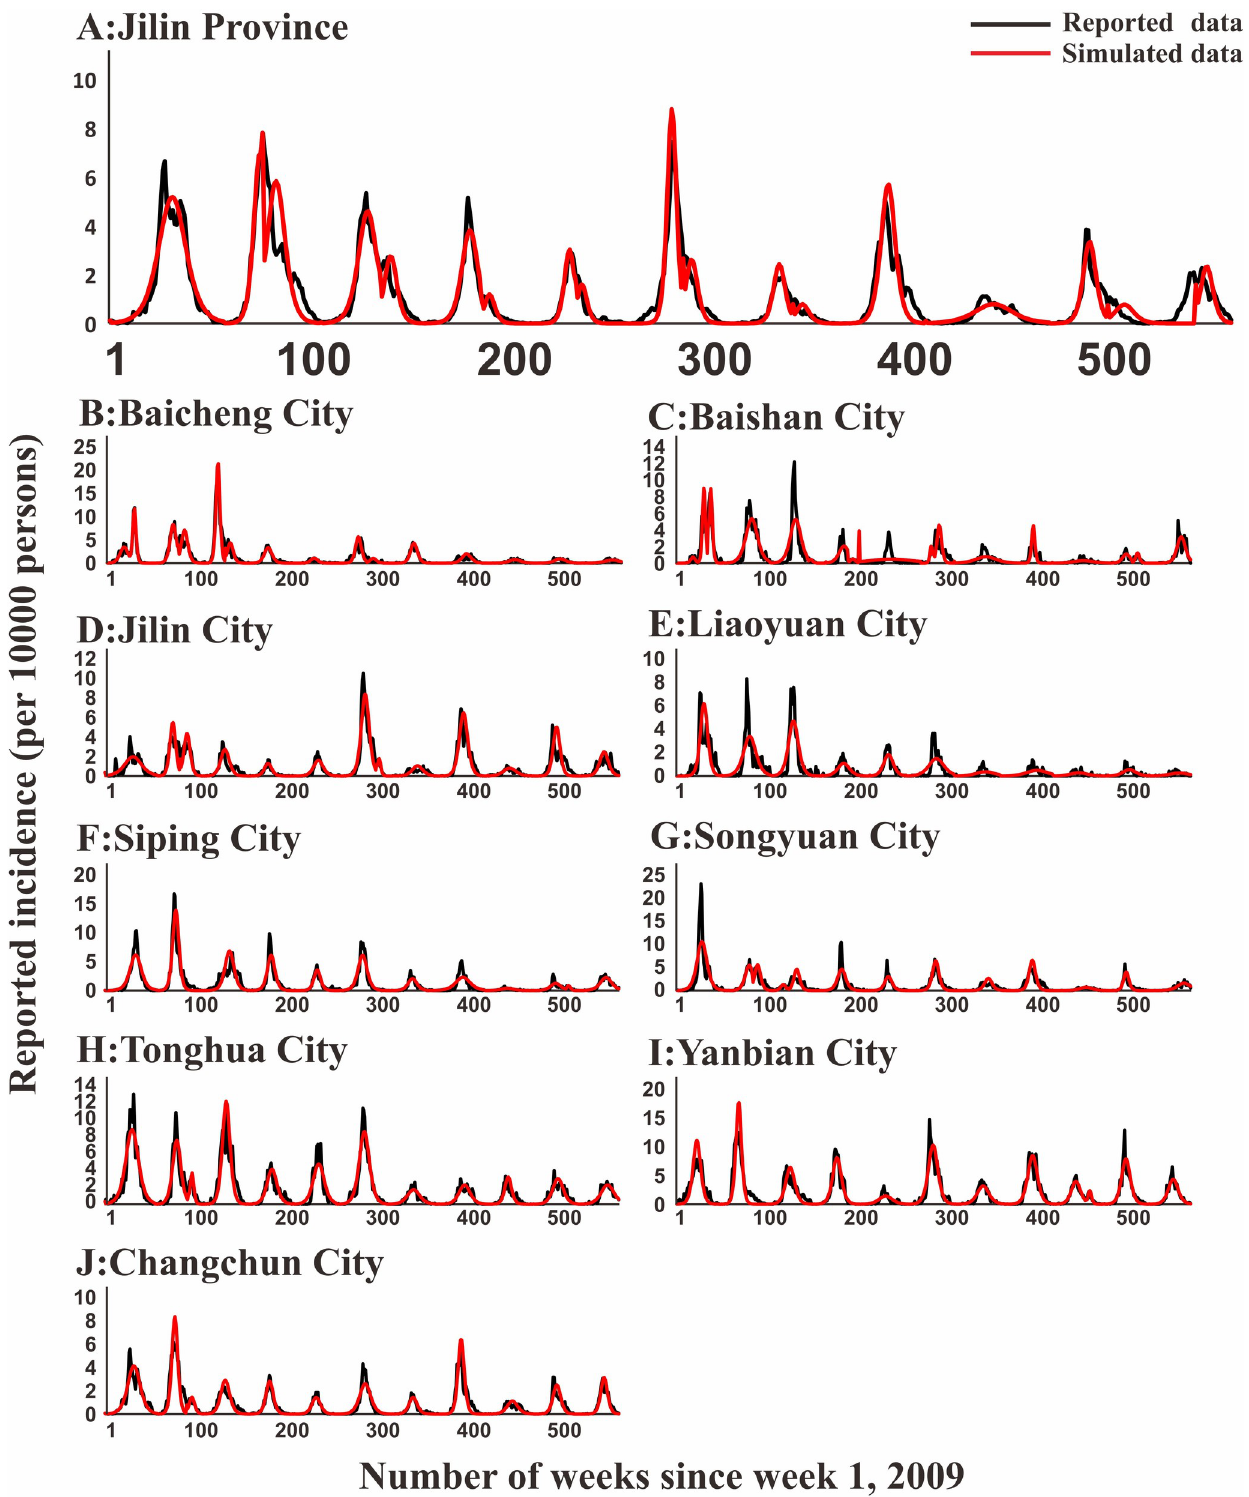
Fig 6. Epidemics of HFMD and LDE model fittings within Jilin Province and its 9 regions. (A: Jilin Province; B: Baicheng City; C: Baishan City; D: Jilin City; E: Liaoyuan City; F: Siping City; G: Songyuan City; H: Tonghua City; I: Yanbian City; J: Changchun City).